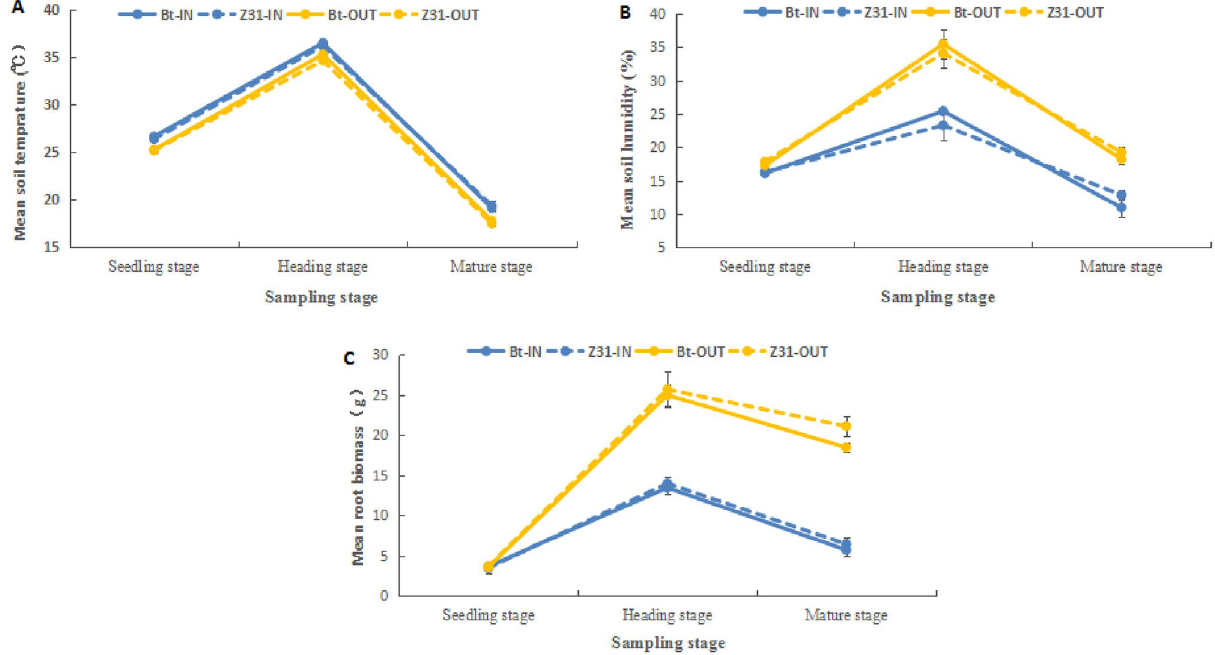
Figure 1. The mean soil temperature ( A ), soil humidity ( B ), and maize root biomass ( C ) of the different experimental treatment plots at different sampling